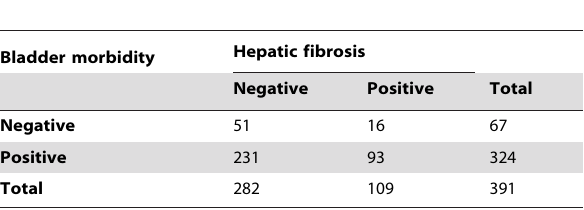
Table 3. Bladder and liver co-morbidity in the two co- endemic communities